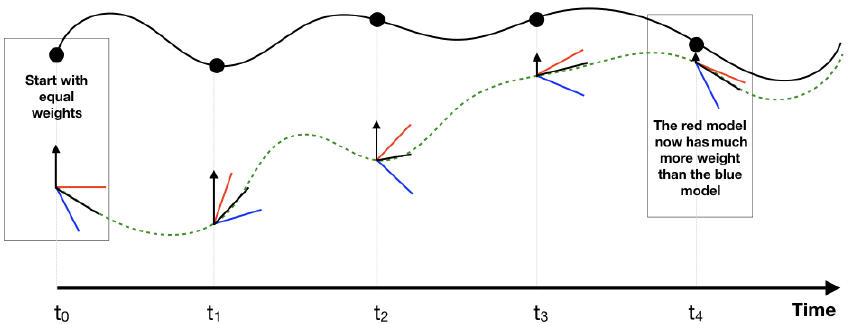
Figure 5. At each observation (dots) of the truth (continuous black line), the weights of the imperfect models (red, blue) are updated which gives a new supermodel solution (green dotted line). The black arrows indicate the nudging to the truth.